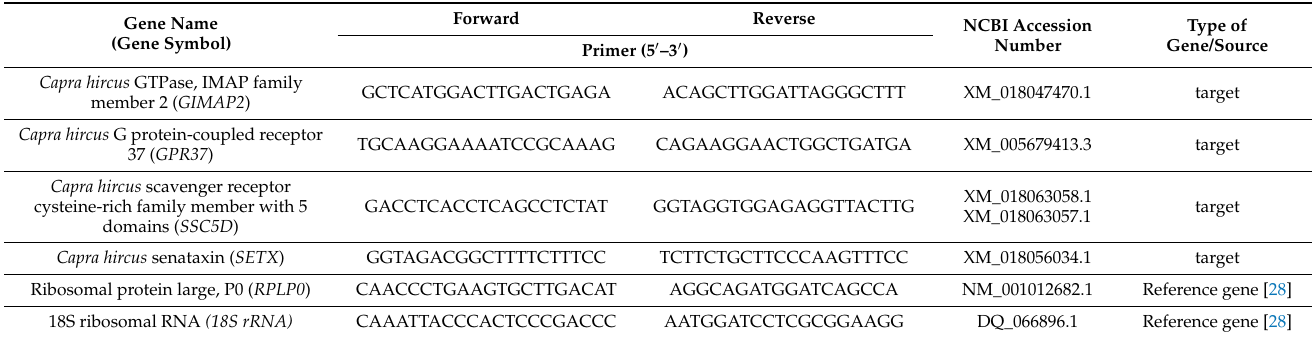
Table 1. Names, symbols, and NCBI accession numbers of genes and primers used in RT-qPCR verification of the microarray